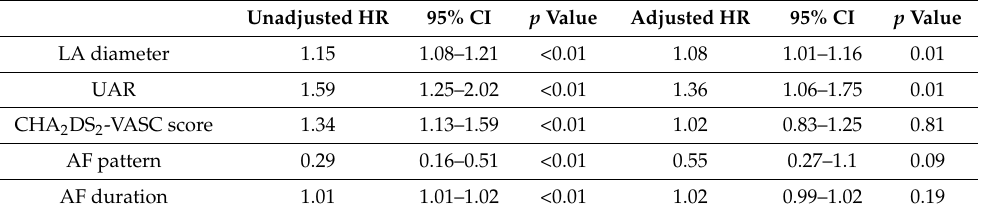
Table 2. Multivariable regression analyses of the parameters which were found to be correlated with recurrence after univariable regression analyses.